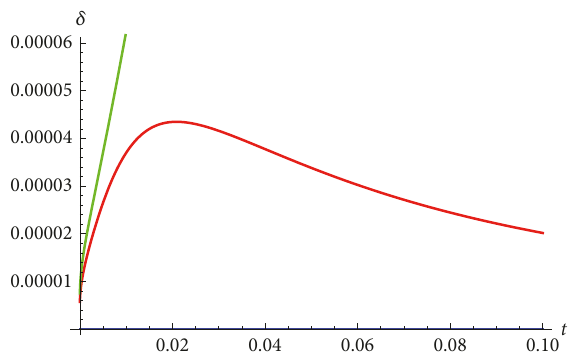
Figure 5: The diagram of the evolution of the parameter 𝛿 with respect to the cosmological time 𝑡 . For illustration, two example values of the parameter 𝐴 are chosen: 𝐴 = −100 km / s Mpc (the top green curve) and 𝐴 = −200 km / s Mpc (the middle red curve). For comparison the Λ CDM model with the parameter 𝛿 = 0 is represented by the bottom blue curve. Here, the value of the parameter 𝐵 is equal to 1. The cosmological time 𝑡 is expressed in s Mpc /